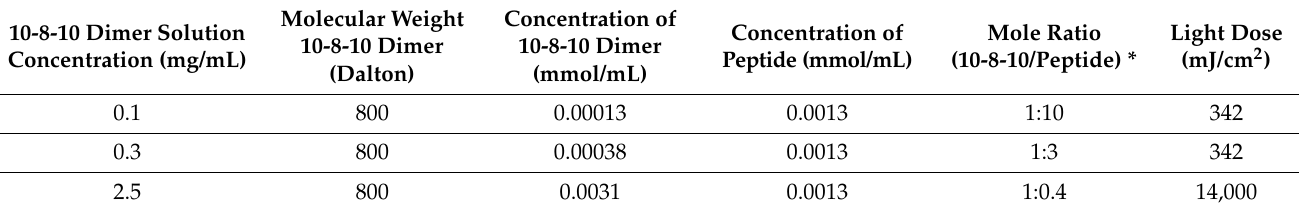
Table 2. Reaction conditions used to study pentapeptide dimerization at